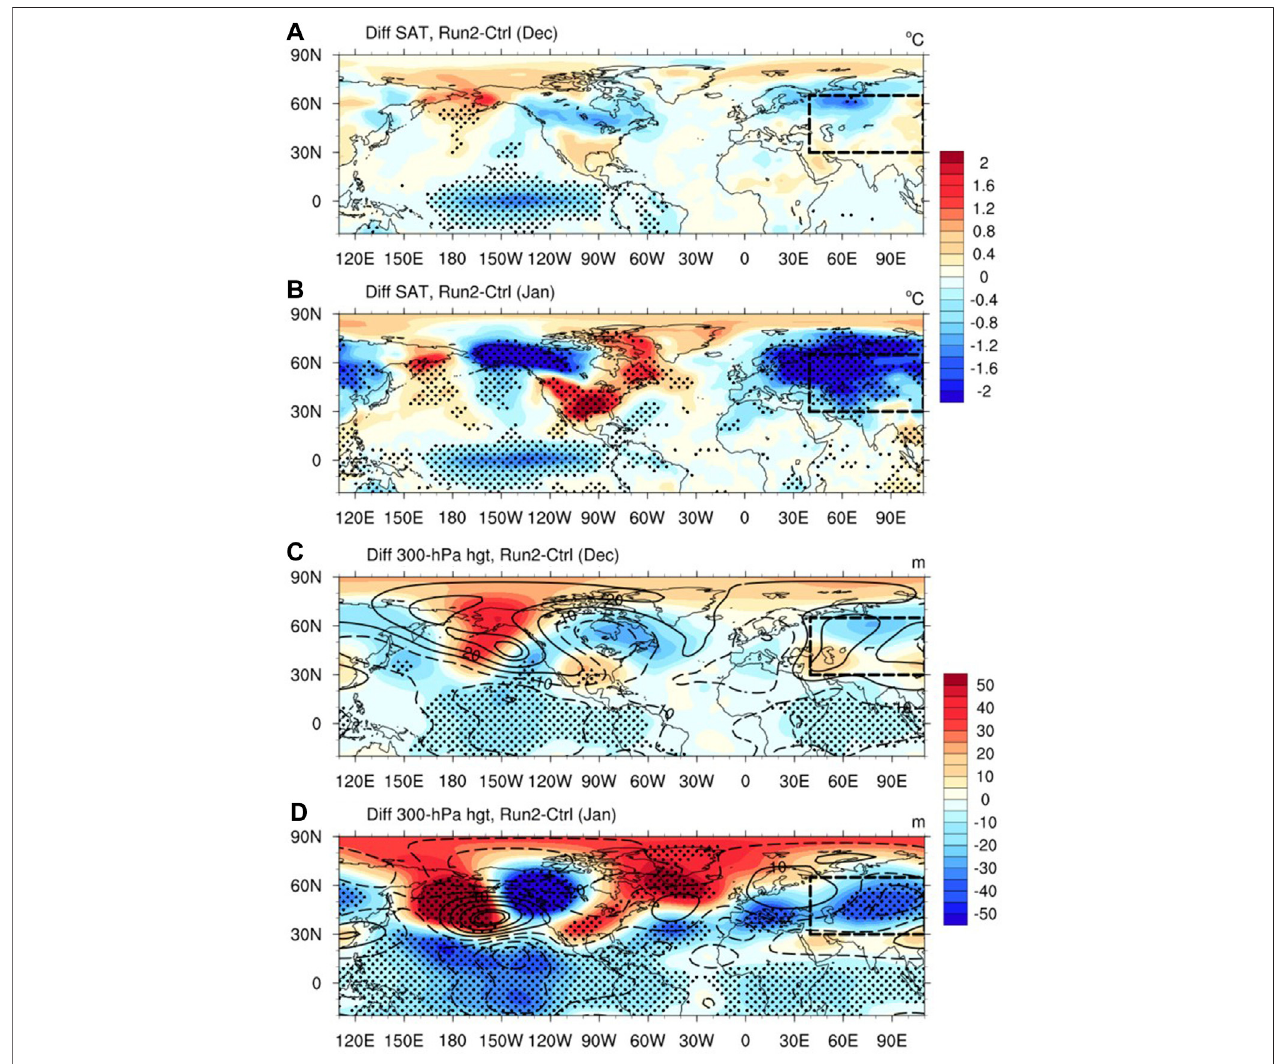
FIGURE 11 | As in Figure 10 but for